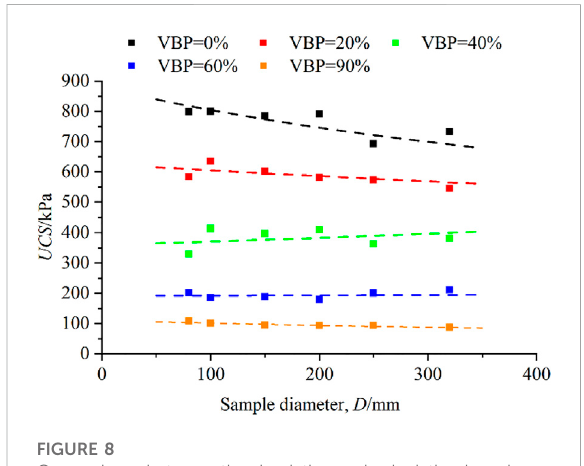
FIGURE 8 Comparisons between the simulation and calculation based on B ă zant theory.